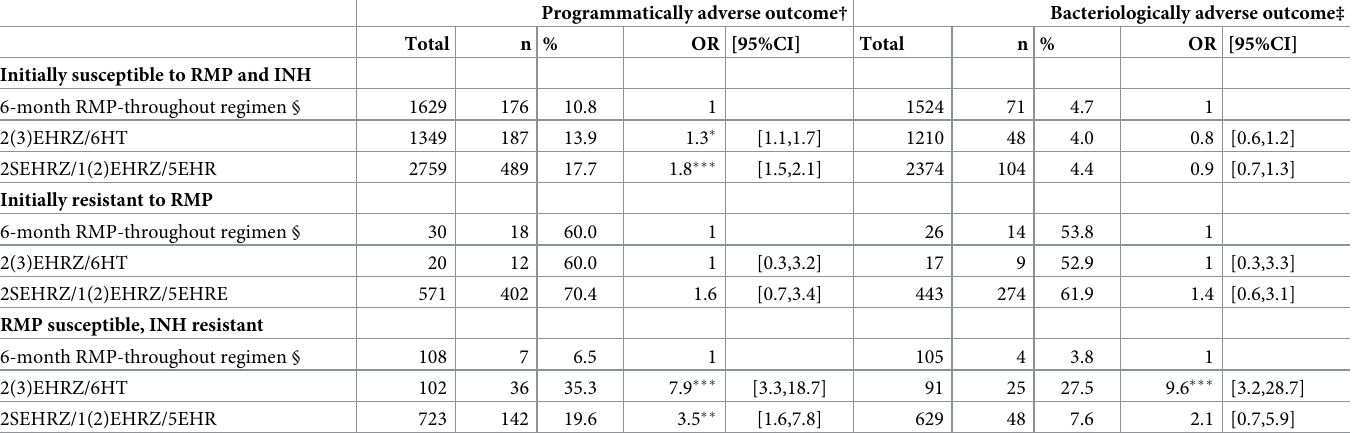
Table 2. Effect of treatment regimen on outcome, by initial resistance profile, in 7291